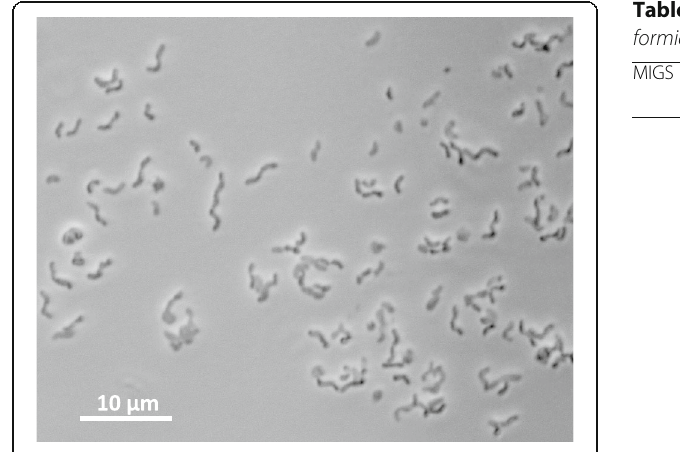
Fig. 1 Photomicrograph of cells of D. formicivorans strain Pf12B T . Cells were grown with formate (10 mM) and yeast extract (0.5 g l -1 ) in the presence of sulfate for 2 days